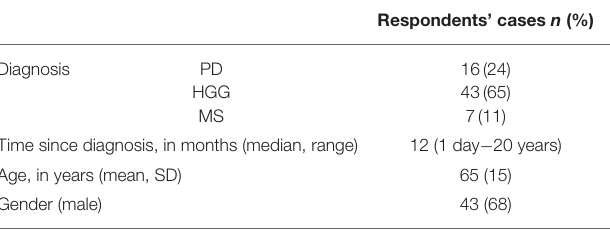
TABLE 2 | Demographics and diagnosis of respondents’ cases.